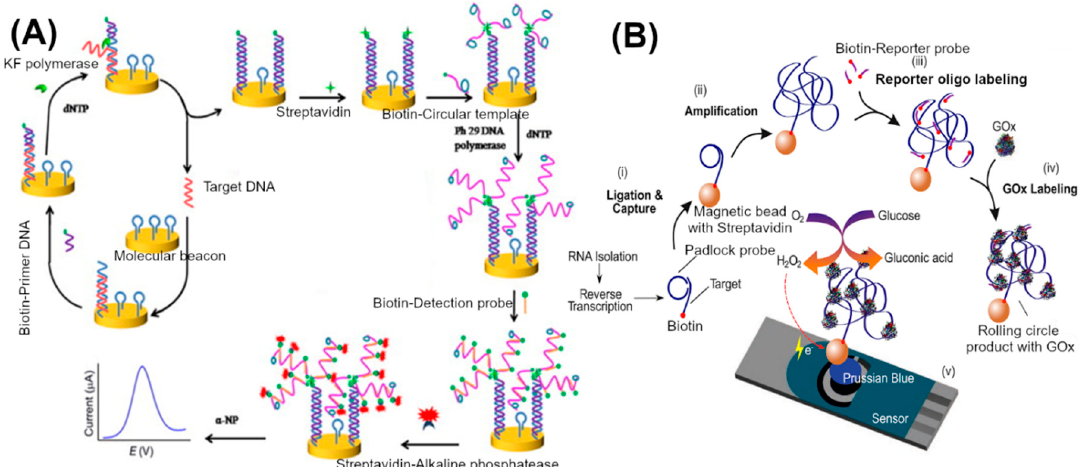
Figure 4. Enhancement of nucleic acid detection by employing polymerase and other isothermal amplification approaches on the electrode surface. ( A ) Strand displacement reaction and rolling circle amplification coupled system [78]. ( B ) Ligation and rolling circle amplification coupled system [68]. Adapted with permission from cited sources.